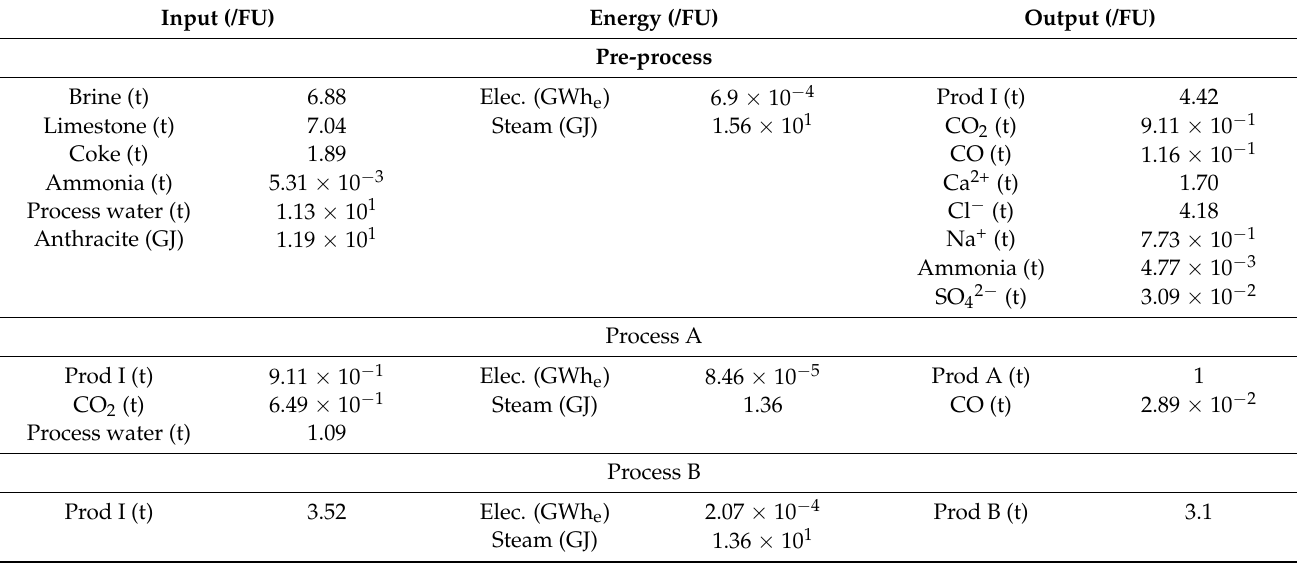
Table 5. Calculated inventory (main results) for the production processes.